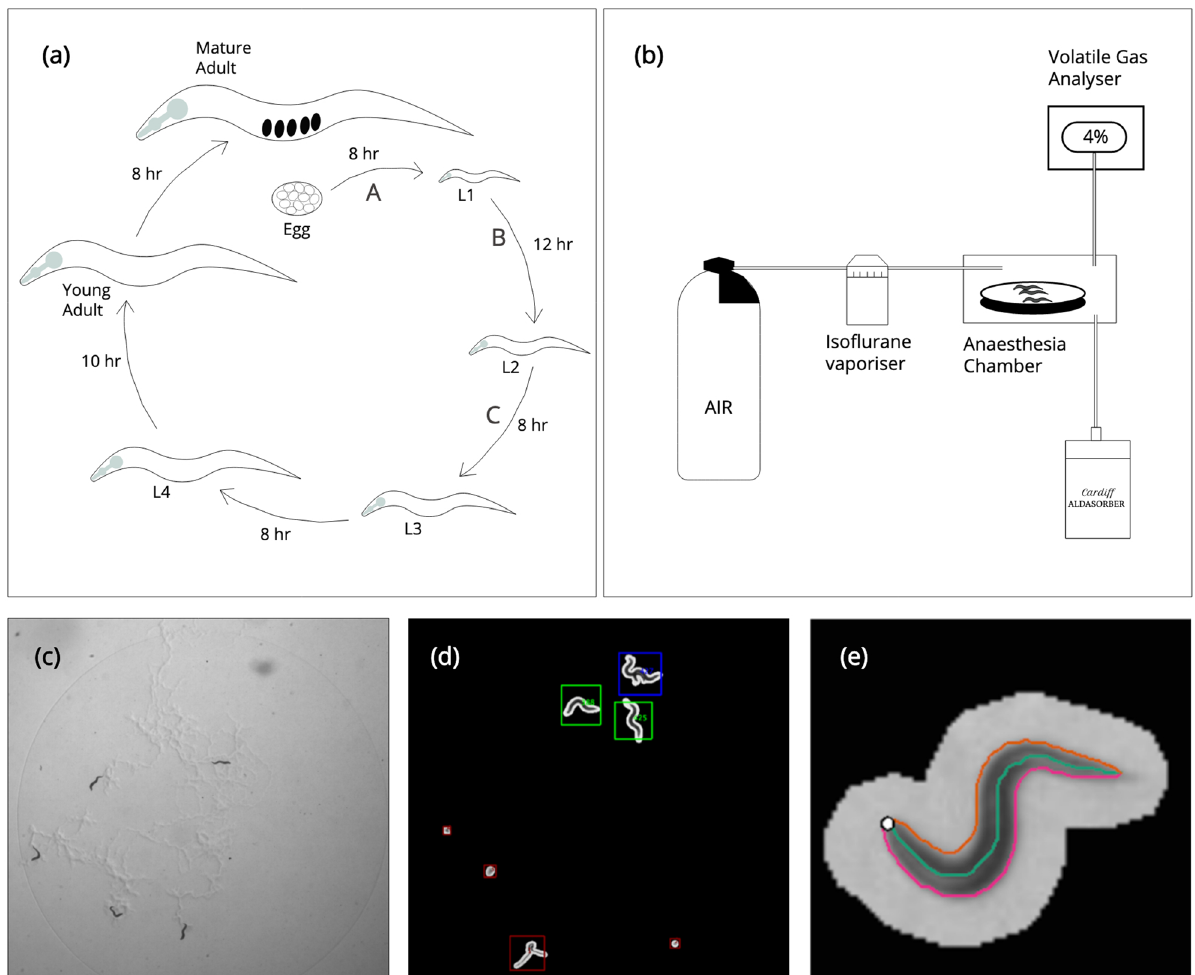
Figure 1. Experimental setup and worm tracking. ( a ) Life cycle of C. elegans hermaphrodite at 22 °C from egg to mature adult via larval stages. Capital letters refer to periods of neurogenesis: A, during proliferation phase of embryogenesis leading to 222 neurons at hatching; B, 74 neurons added during L1; C, 6 neurons added during L2. ( b ) Anaesthesia apparatus. Air flows from a pressurised cylinder into a vapouriser, and is saturated with a variable concentration of the volatile gas anaesthetic isoflurane. It then passes into a chamber holding plates of C. elegans . The delivered concentration is measured directly with an optical analyser, and titrated to desired value. The output from the chamber flows into the Cardiff Aldasorber, which binds anaesthetic gases for safe disposal. ( c ) Video still of experimental plate, showing 5 L1 larvae on an E. coli OP50 lawn. ( d , e ) Larva segmented from background using intensity threshold to extract the worm contour and